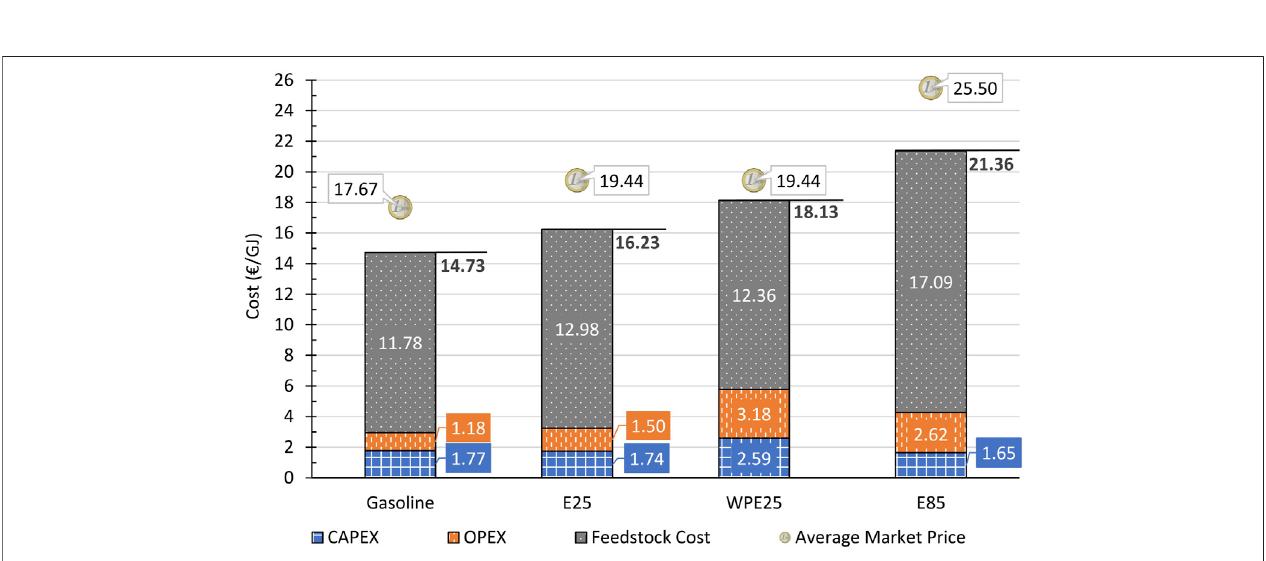
FIGURE6| EconomiccomparisonoftraditionalgasolineagainstcommercialbioethanolblendsandproposedWPEblend.E25:gasoline/bioethanolblend75/25% v/v. WPE25: gasoline/plastic waste pyrolysis-sourced ethanol blend 75/25% v/v. E85: gasoline/bioethanol blend 15/85% v/v (for references, see Table 4 ).